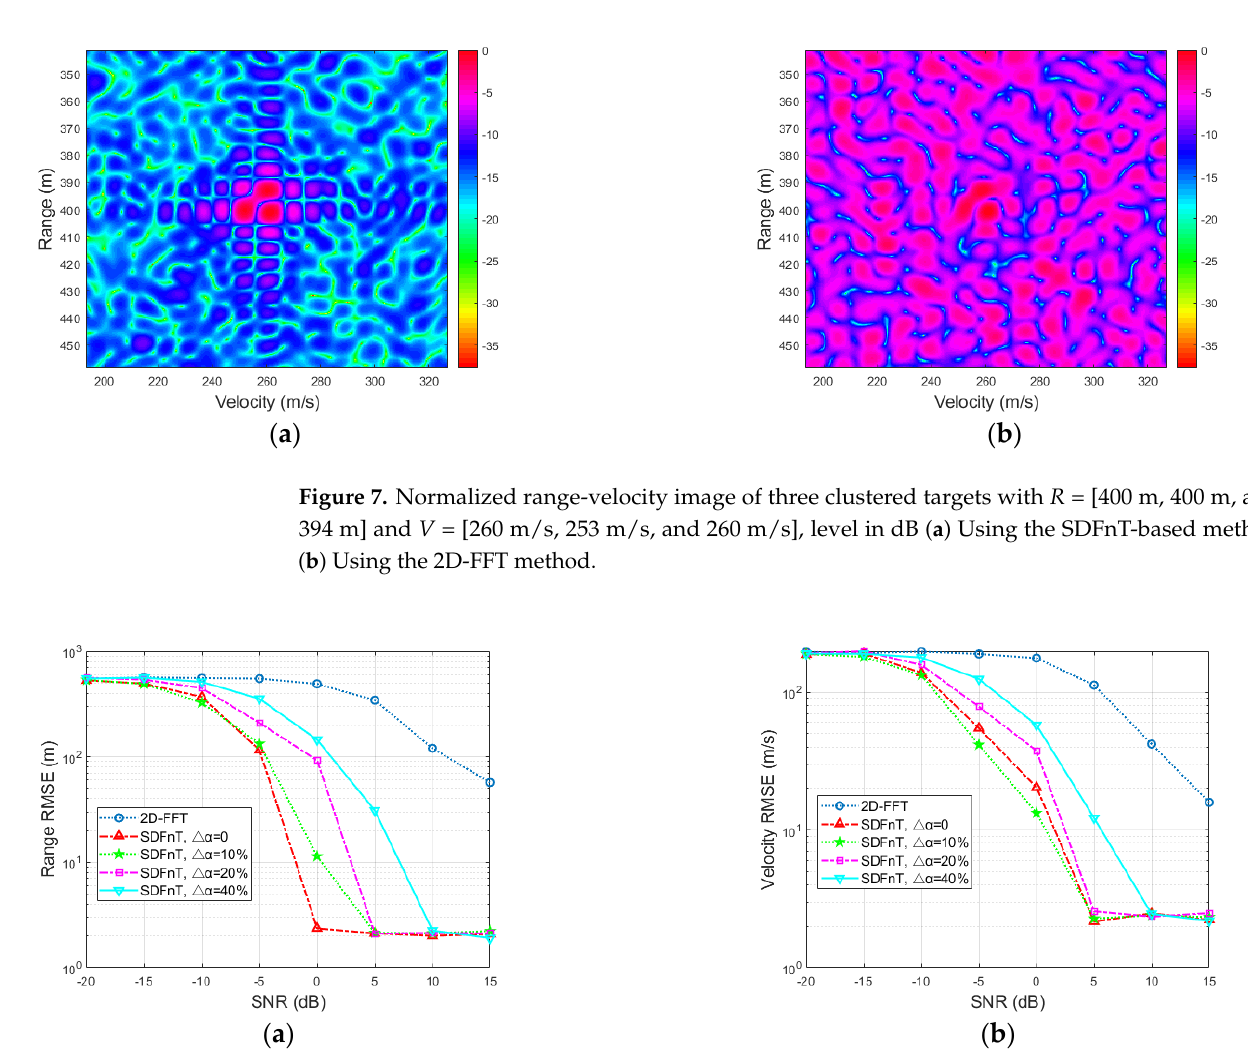
Figure 8. Clustered multi-target results in terms of SNR ( a ) RMSE for the range estimation ( b ) RMSE for the velocity estimation.